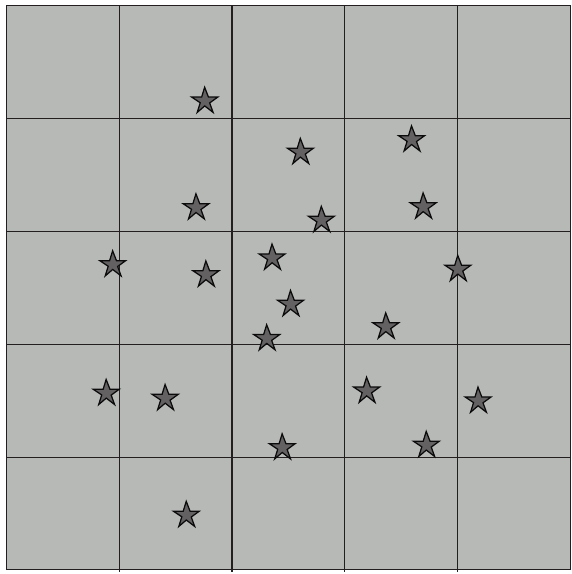
Figure 9: Test results of the unused filter.